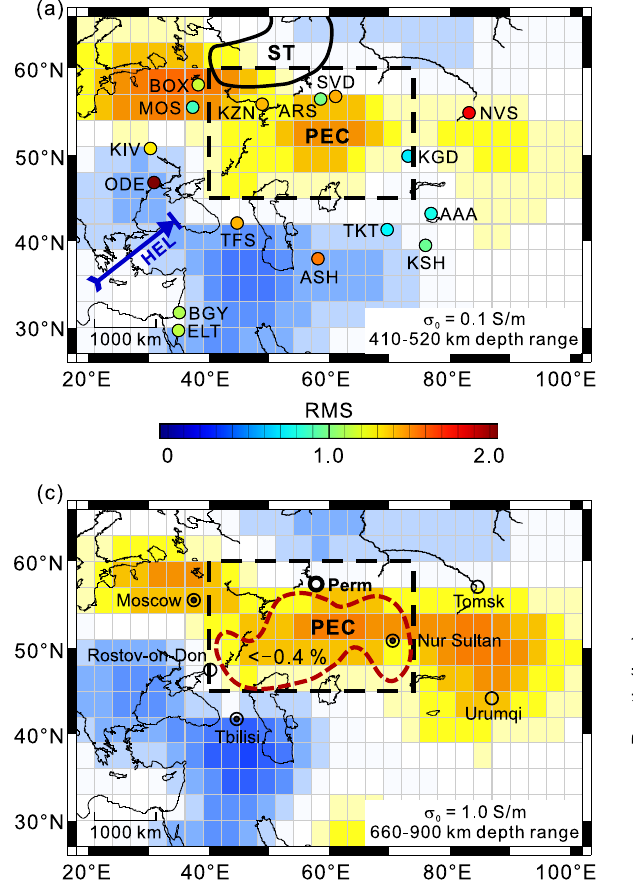
Fig. 2 | Electrical conductivity images of the mantle beneath the study area. Conductivity slices at depths of ( a ) 410 – 520km, ( b ) 520 – 660km and ( c ) 660 – 900km. Coloured dots with three-letter codes in ( a ) represent the geomag- neticdepthsounding(GDS)stationslistedinTab.S1,withthecoloursindicatingthe root mean square (RMS) of the data mis fi t at the end of the inversion. The areas enclosedbysolidanddashedblacklinesdenotethelocationsoftheSiberianTraps (ST) when they formed 4 and the Perm anomaly near the core-mantle boundary 14 ,